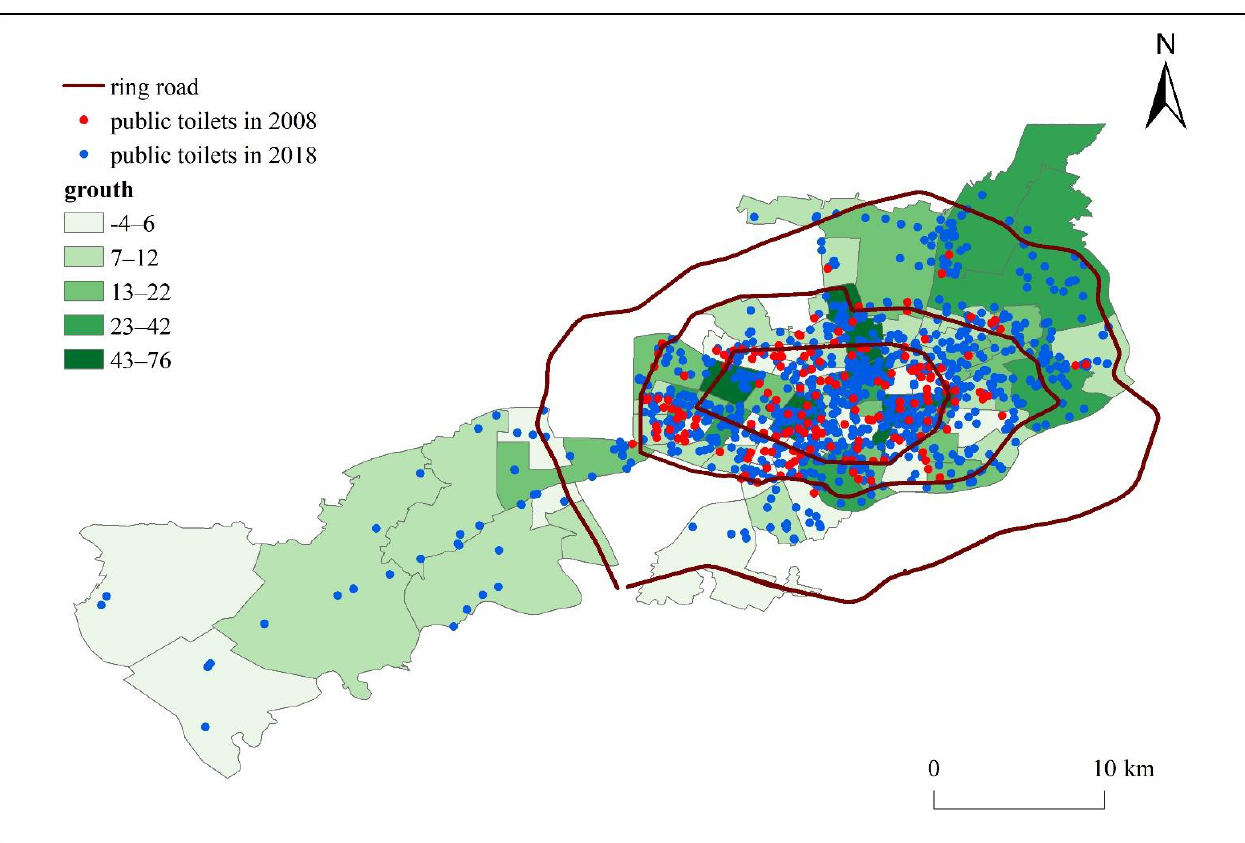
Figure 5. Distribution of public toilets POI increase in Shenyang.